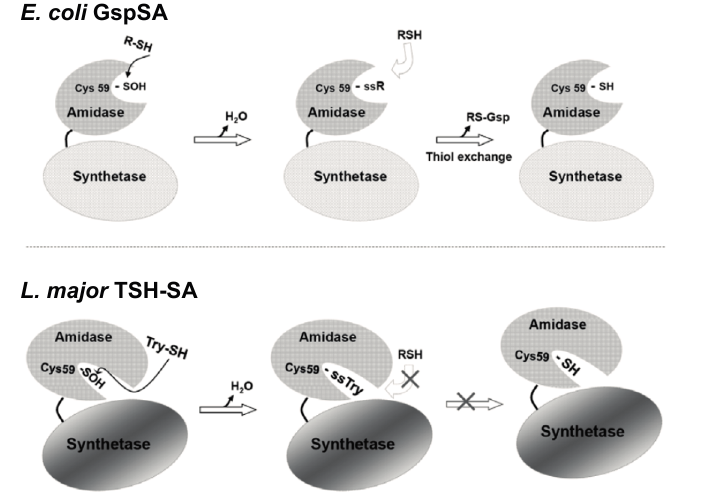
Figure 4. Schematics illustrating the different redox regulation mechanisms for E. coli. GspSA and parasitic protozoa TSH-SA [26]. The recovery of Gsp amidase activity in E.